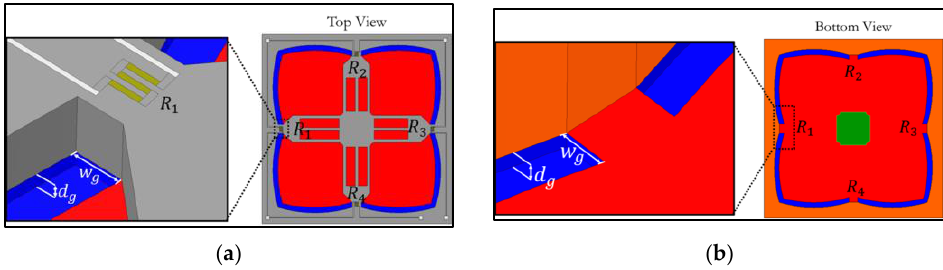
Figure 4. Annular groove: ( a ) grooves on top of diaphragm (𝐴𝐺 − 𝑇𝑜𝑝) and ( b ) grooves at bottom of diaphragm (𝐴𝐺 − 𝐵𝑜𝑡𝑡𝑜𝑚) . (Note: not to scale.)